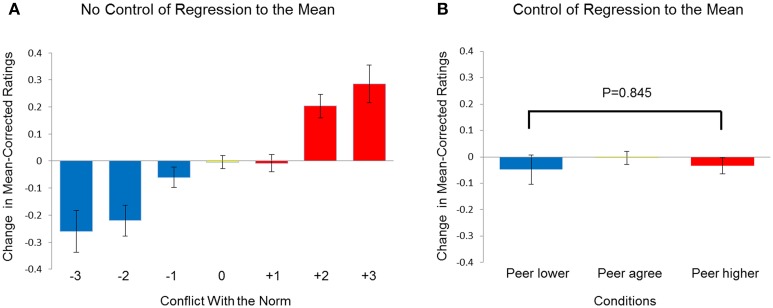
Social conformity effect in study 1. (A) Change in mean-corrected ratings after 30 min (mean-corrected 30-min re-rating minus the mean-corrected initial rating) as a function of conflict with the norm (−1, −2, −3 = group ratings were more negative than initial ratings by 1, 2, 3, points;; 0 = no conflict; +1, +2, +3 = group ratings were more positive than initial ratings by 1, 2, 3 points). (B) Change in mean-corrected ratings after 30 min as a function of conditions. To control for regression to the mean, the results were from subsets of faces with initial ratings matched between the peer-higher and peer-lower conditions. Error bars indicate standard error.